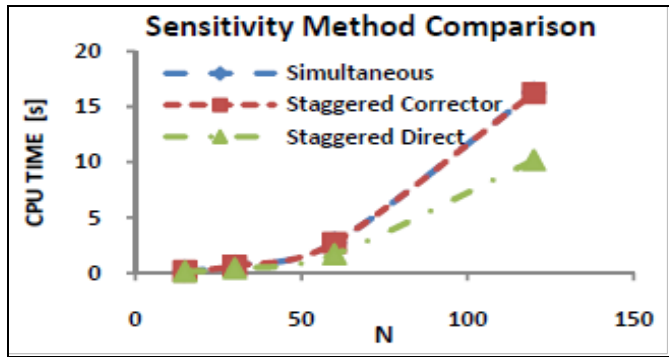
Figure 9: Comparison of the CPU time for the numerical sensitivity methods.